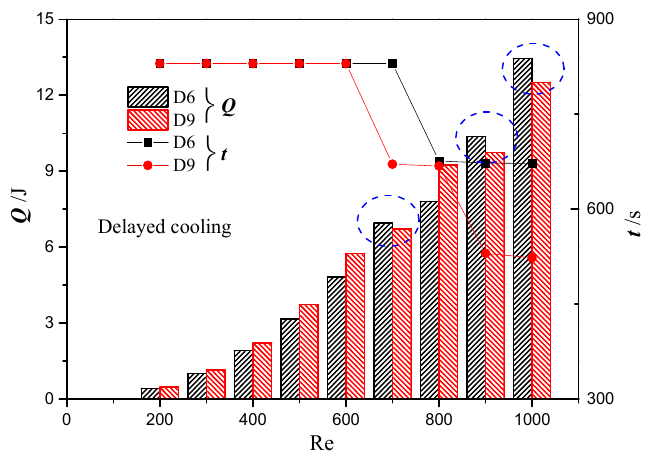
Figure 14. The variation of power consumption and liquid cooling time for designs D6 and D9 under delayed cooling scheme at di ff erent Reynolds numbers.